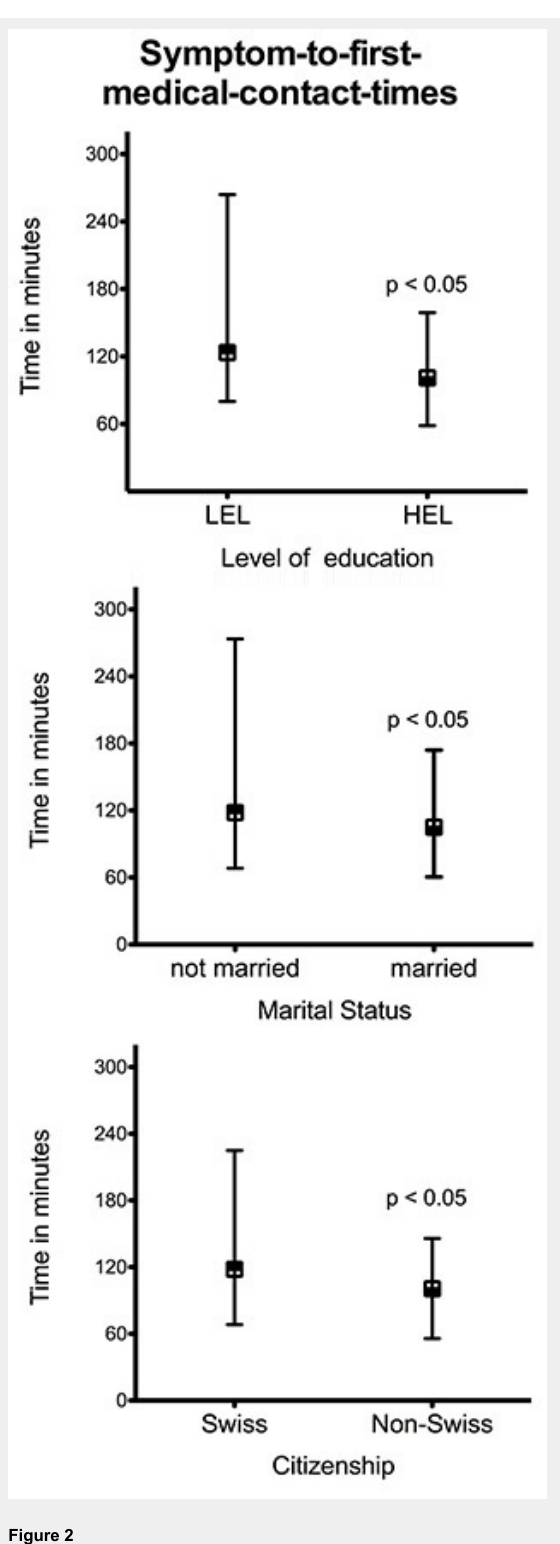
Figure 2 Median symptom-to-first-medical-contact times with interquartile ranges for the different socioeconomic groups. Patients with a low level of education, unmarried patients and Swiss citizens had significantly longer symptom-to-first-medical-contact times (p